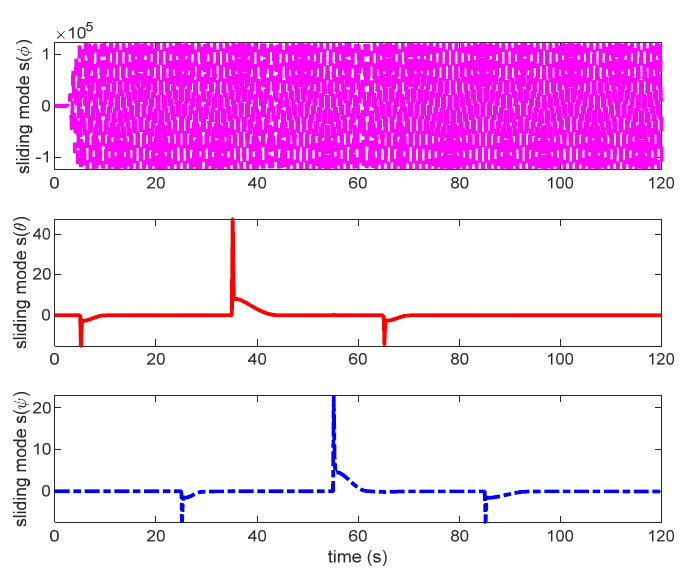
Figure 11. Control surface faults estimation.